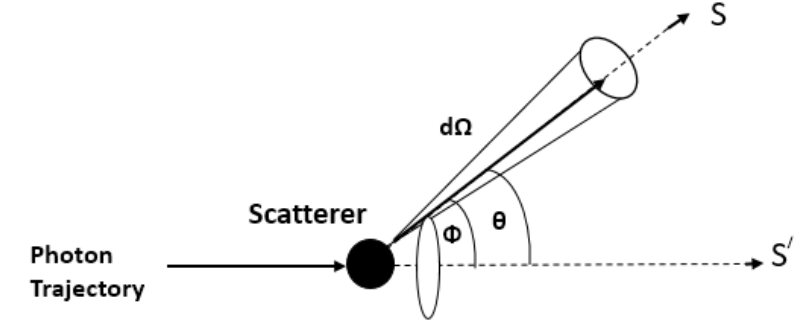
Figure 2. A photon initially traveling from S (cid:48) is scattered into a differential solid angle d Ω along S . Here φ corresponds to the azimuthal angle from the scattered trajectory, and θ corresponds to the polar angle from the initial